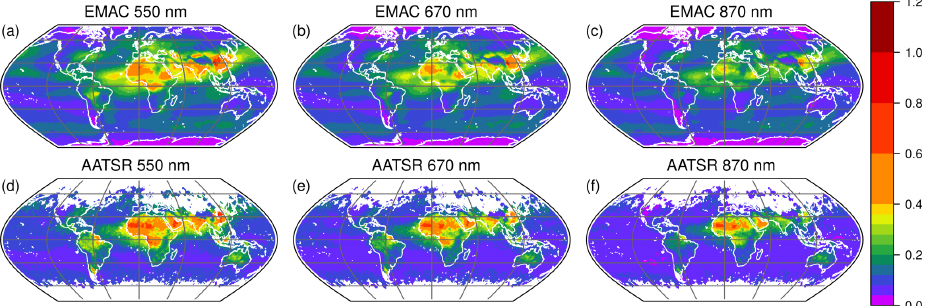
Figure 8. Annual mean for 2011 of the AOD at (from left to right) 550, 670 and 870nm wavelength observed by AATSR ( d, e, f ; SU-ATSR algorithm version 4.3) and simulated by EMAC (a, b, c) at T106L31